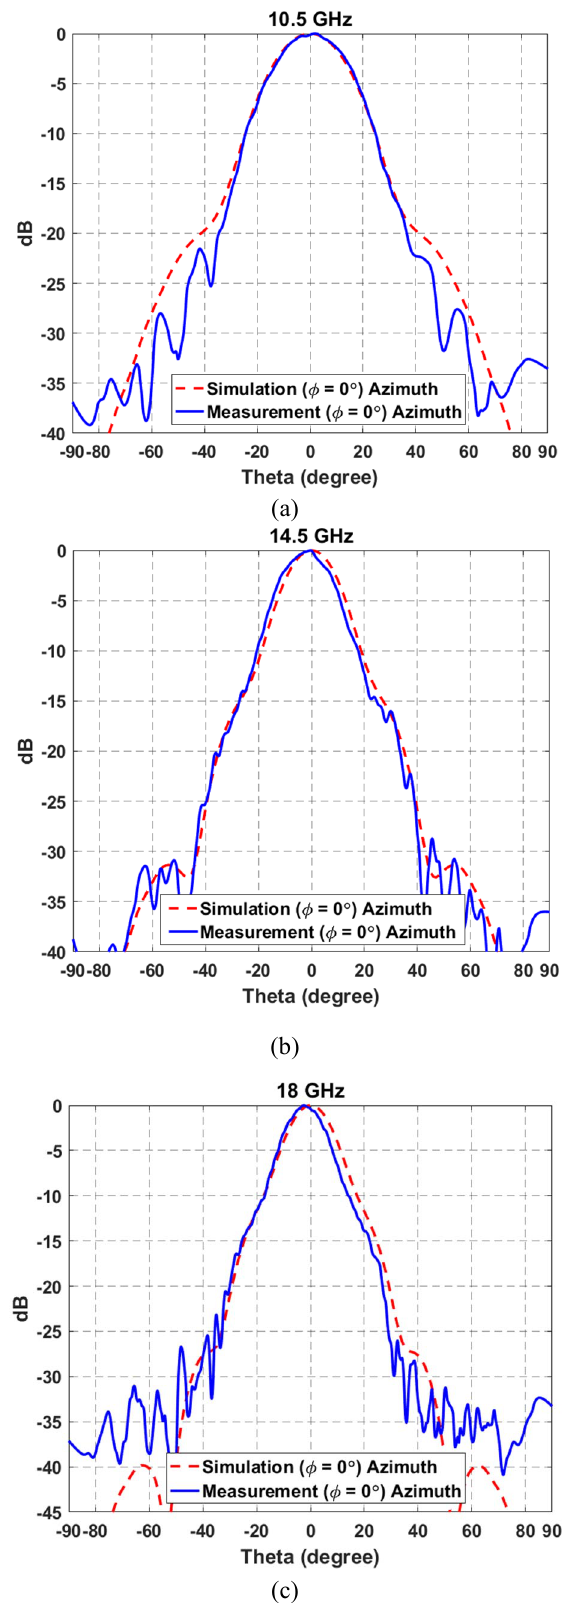
Figure 9: The measured and simulated (with PLA/nickel) co-polarization normalized patterns for E-plane (elevation) at (a) 10.5 GHz (b) 14.5 GHz (c) 18 GHz.